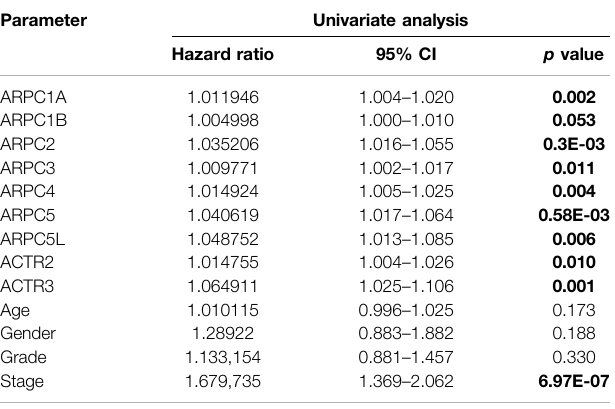
The bold values represent the factors that signi fi cantly associated with poor survival in HCC patients